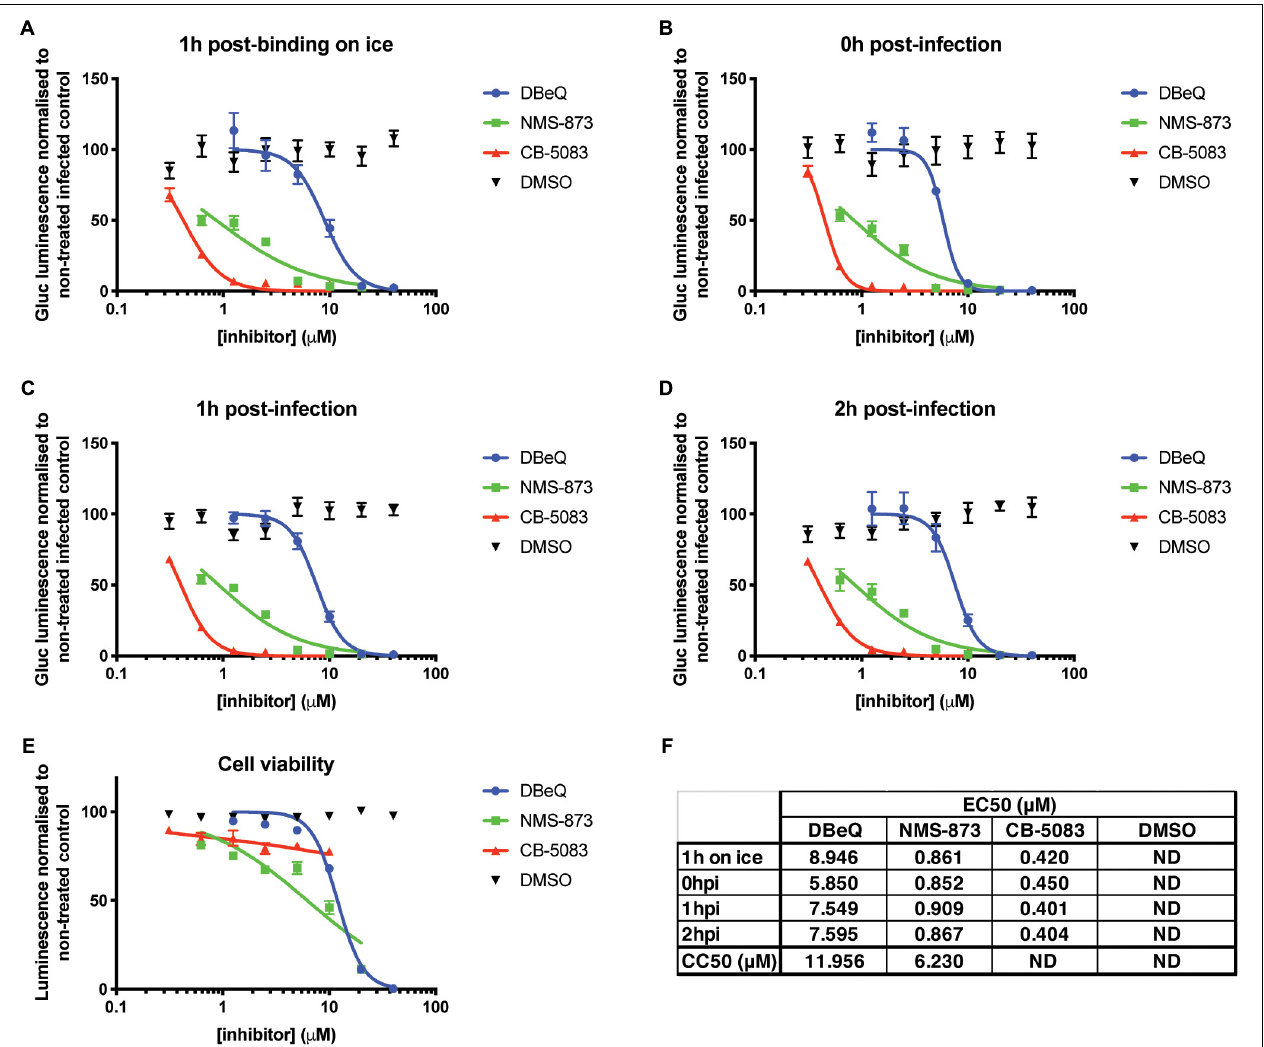
FIGURE 2 | VCP chemical inhibition affects CHIKV infection. Thirty thousand HEK 293T cells per well in 96-well plates fibronectin coated were treated with VCP inhibitors CB-5083, NMS-873, DBeQ, or DMSO control at the times indicated on the panels relative to infection with 30,000 pfu of Gluc-tagged CHIKV per well. At 16 hpi, luminescence was quantified from 50 µ L of supernatant. Data are presented as % luminescence compared to non-treated infected cells in y -axis, and as concentration of inhibitor ( µ M) in the x -axis. (A) Virus was allowed to bind to the cells for 1 h on ice before inoculate was removed and virus-free media with compounds were applied and cells moved back to 37 ◦ C. (B) Virus was applied to the cells at the same time as the compounds, removed after 1 h and virus-free media with compound was replaced on the cells. (C,D) Virus was applied for 1 or 2 h, respectively, after which inoculum was removed and compounds were applied. (E) Cytotoxicity of the compounds was assessed for each compound by CellTiter-Glo assay without infection at 16 h post treatment. (F) EC50 and CC50 values from panels A–E were calculated using the non-linear regression analysis (inhibitor) ( µ M) vs. normalized response variable slope function of GraphPad Prism. The data presented in panels A–E are mean ± SEM of three independent experiments. ND, not